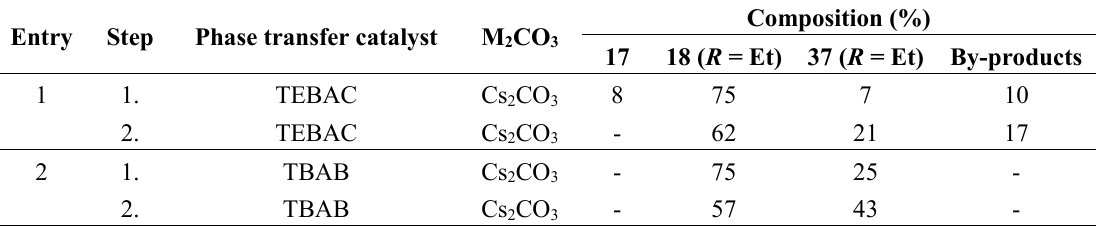
Table 11. Two-step ethylation of ethoxycarbonylmethylphosphonate ( 17 ) with ethyl iodide under bromide